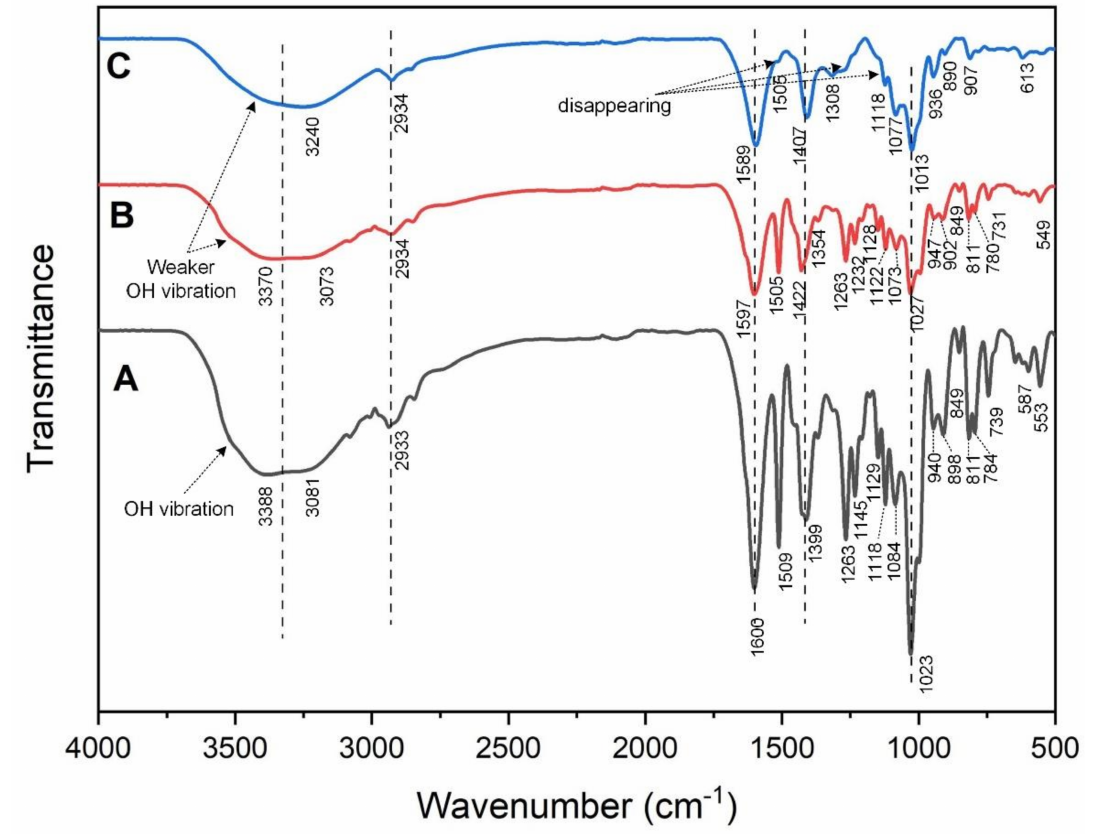
Figure 3. Fourier transform infrared (FTIR) spectroscopy observation result: ( A ) control film (SA); ( B ) SA/KC film; ( C ) crosslinked SA/KC